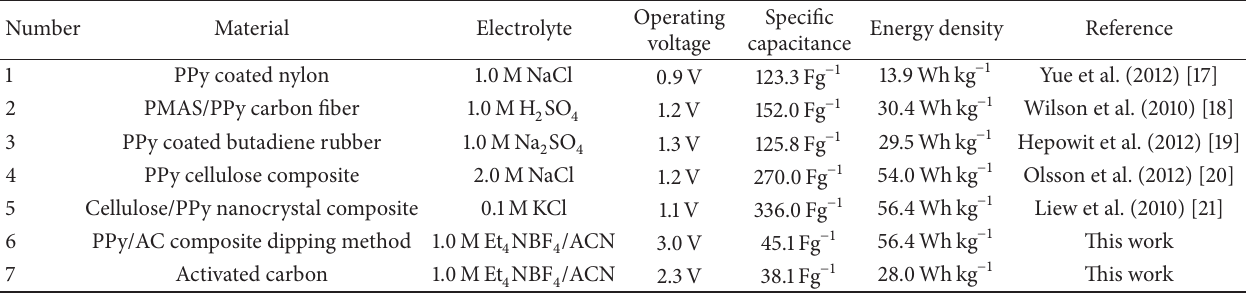
Table 2: Comparison with the operating voltage of prepared PPy/AC composite electrode and several reported PPy composite